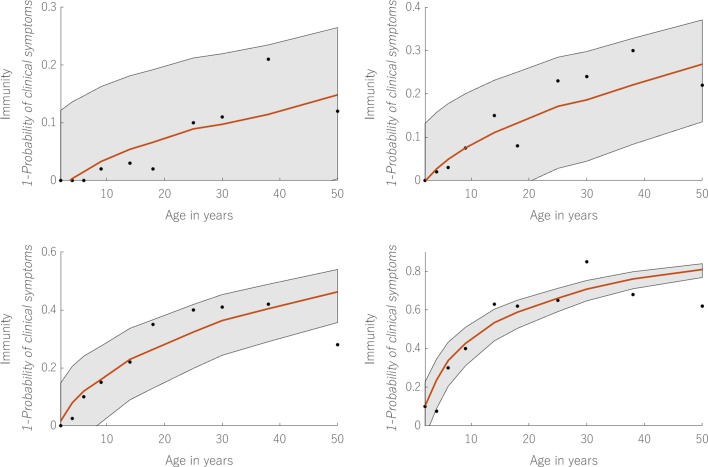
Model fit to immunological data.Displays the simultaneous fit to 4 measured relationships between age and clinical immunity. The black dots refer to the data points offering a measurement for clinical immunity in each of these endemic settings. The red line shows the output of 1-[(imm_a*exp(-0.1(cml-1))+exp(-imm_b*(cml+1)))/sqrt(lvl)], for the estimated values of imm_a and imm_b taking as inputs the mean values of cml and lvl (taken from the model output) in individuals of age given by the X-axis. The grey bands represent the 95% credible intervals.